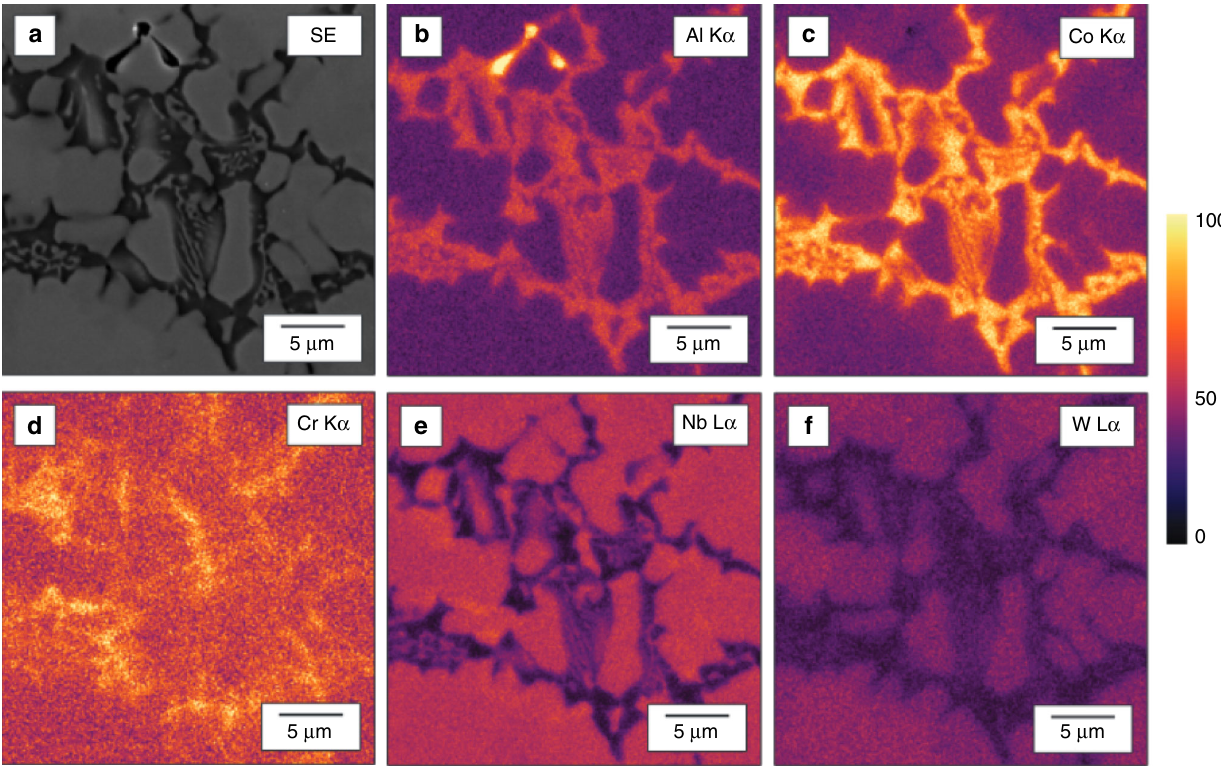
Fig. 6 Energy-dispersive spectroscopic (EDS) map of a hard alloy. An X-ray EDS map of the as-cast microstructure of Co 33 W 07 Al 33 Nb 24 Cr 03 . a Secondary electron image and X-ray intensity maps produced by integrating b Al K α , c Co K α , d Cr K α , e Nb L α , and f W L α X-ray signals. The color scale represents the relative intensity based on the number of counts per pixel. The map suggests that the dendritic region of the microstructure is rich in Nb and W while the eutectic inter-dendritic region comprises two phases, one rich in Nb and the other primarily composed of Al, Co, and Cr